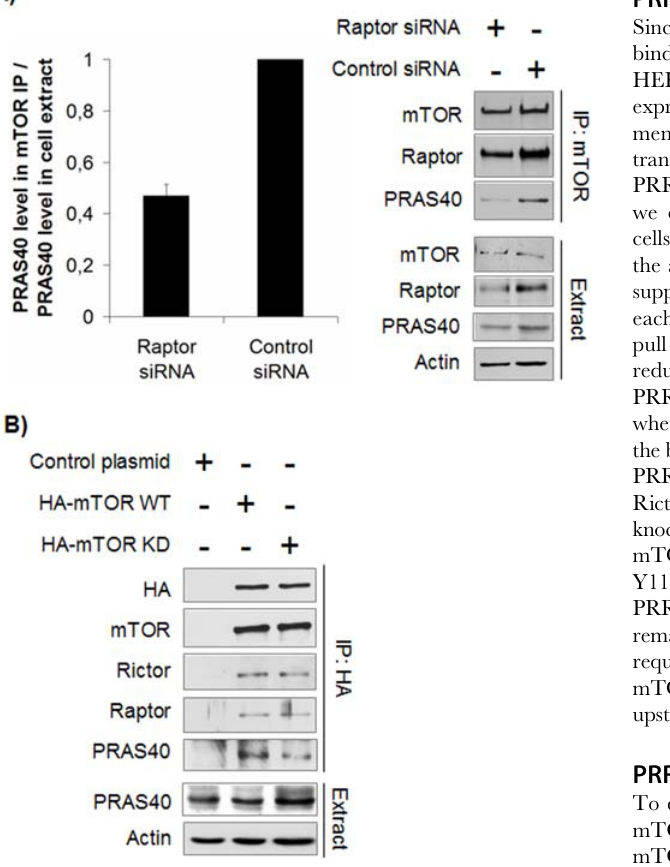
Figure 2. PRAS40 interacts with mTORC1. A. PRAS40 binds mTOR via Raptor. HEK293 cells were transfected with Raptor or control siRNA vectors and incubated for 4 days, followed by mTOR IP and immunoblotting. mTOR IPs and cell extracts were probed with antibodies directed against the indicated proteins. Since knock down of Raptor reduced the cellular amount of PRAS40, the PRAS40 signal in the IPs was quantified relative to PRAS40 levels in the corresponding extract. Quantitations were averaged over three independent experi- ments. Raptor knock down reduced the amount of PRAS40 associated with mTOR by 50%, as compared to control cells. B. mTOR kinase domain is involved in PRAS40 binding. HEK293 cells were transfected with a plasmid expressing wild type (WT) HA-mTOR or kinase dead (KD) HA-mTOR or an empty control plasmid, and incubated for 48 h followed by extract preparation and IP with an anti-HA antibody. PRAS40 levels in the extracts remained unaltered. PRAS40 association with mTORC1 containing HA-mTOR KD was moderately reduced as compared with mTORC1 containing HA-mTOR WT.